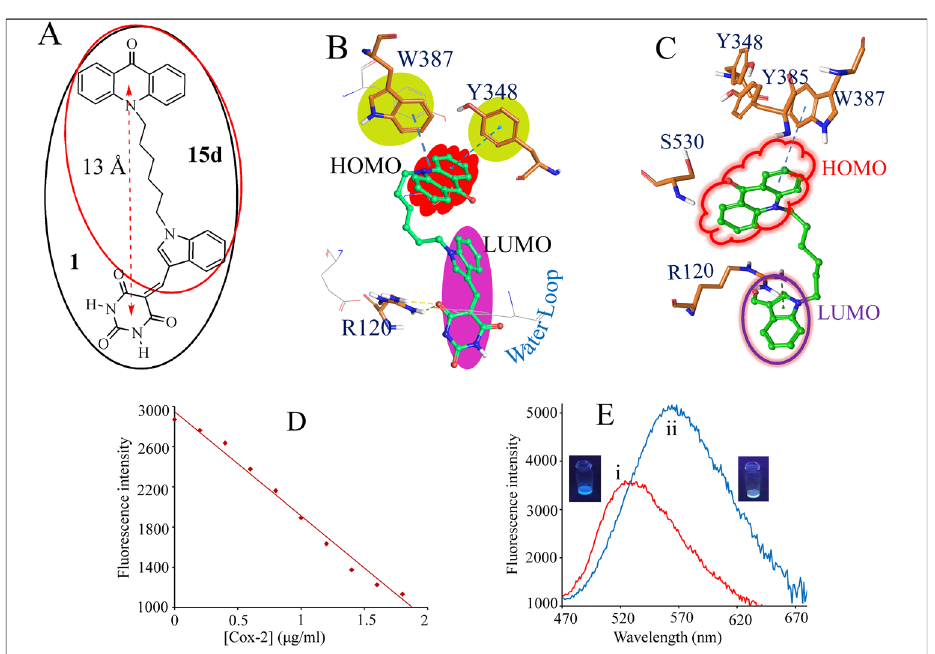
Figure 8. Fluorescence studies supporting the role of water loop: ( A ) Compounds 1 and 15d (15d has CHO at C2-indole). HOMO–LUMO of ( B ) 1 and ( C ) 15d interacting with COX-2. LUMO of 15d did not interact with water loop. ( D ) Change in the fluorescence intensity of compound 1 at 567 nm Vs [COX-2] in H 2 O-DMSO (9:1, v/v). ( E ): Fluorescence spectra of: (i) 1 (1 μM) in the presence of lyophilised COX-2 in DMSO-H 2 O (9:1) and (ii) only 1 in DMSO-H 2 O (9:1, v/v). DMSO-H 2 O (9:1, v/v) solvent system was used to keep lyophilized enzyme as much as possible free of water. The concentration of the enzyme taken in DMSO-H 2 O (9:1, v/v) for fluorescence purpose was not sufficient to record the mass spectra.